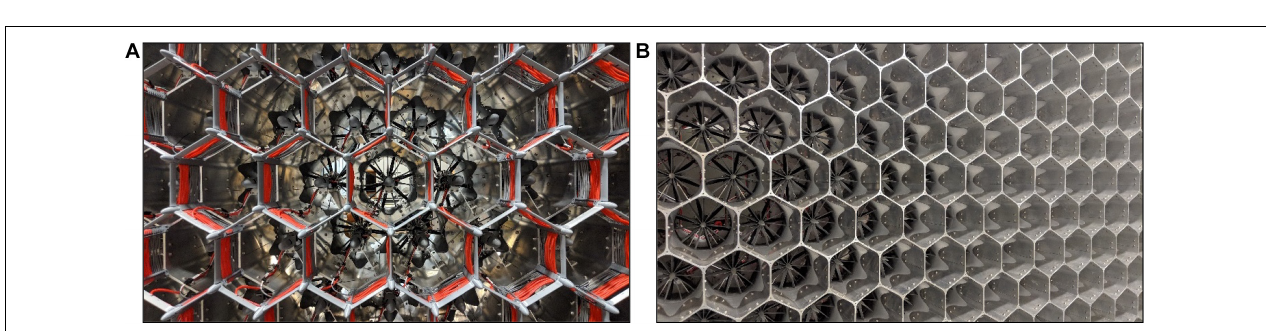
FIGURE 2 | The Terraformer: (A) test subject installed in the foreground and roughness element field with elements uniformly actuated in the background; (B) heterogeneous terrain; and (C) annotated individual element assembly.